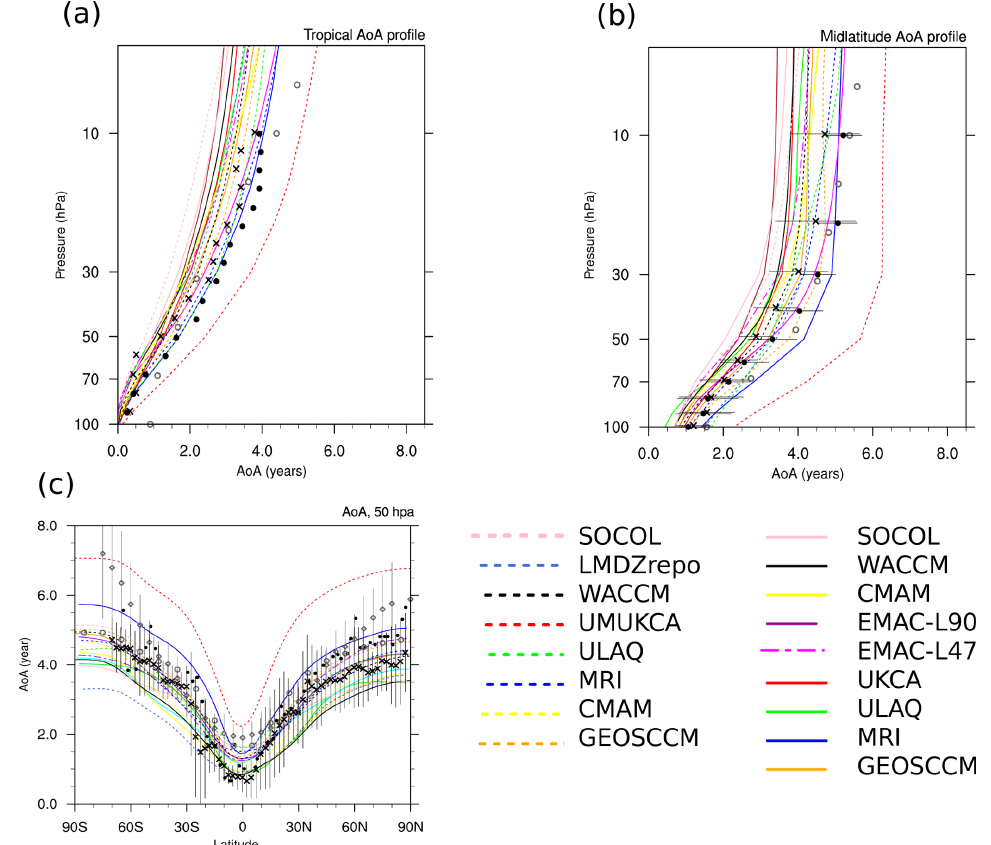
Figure 3. (a) Tropical (10 ◦ N–10 ◦ S) AoA profile, (b) midlatitude (35–45 ◦ N) AoA profile and (c) latitudinal AoA distribution at 50hPa for all analyzed CCMVal-2 models (dashed lines) and CCMI-1 models (solid line), with AoA averaged over the years 1980–2006. AoA profiles are shown together with the observational AoA data derived from airborne in situ measurements of SF 6 (black dots) and CO 2 (black crosses). For the extra-tropics the observations from Engel et al. (2009) and for the tropics the observations of Andrews et al. (2001) are used. Uncertainties of the observational data of Engel et al. (2009) are shown as 1 σ . Observational data of Andrews et al. (2001) were not reported with uncertainties. Moreover, AoA determined from GOZCARDS N 2 O data is used (gray circles) (Andrews et al., 2001; Linz et al., 2017). The latitudinal AoA distribution is shown together with AoA from MIPAS SF 6 data (gray diamond symbols), with AoA from GOZCARDS N 2 O data (gray circle) and with in situ measurements of Andrews et al. (2001) (black cross for CO 2 and black dot for SF 6 ). Error bars of the observational MIPAS data at 50hPa give the range between minimum and maximum